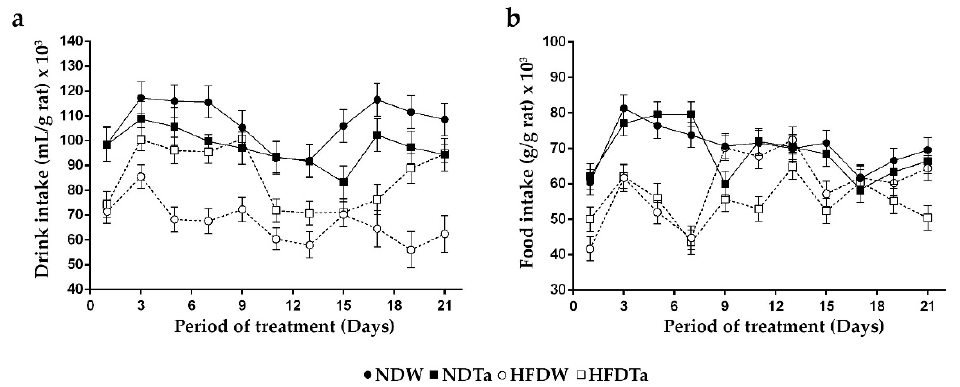
Figure 2. Intake of beverage ( a ) and food ( b ) through a 21-day period since the beverage administration began. Intake values were relativized to the BW of the animals. The graphs include the results of every other day to simplify the figures. Results are expressed as mean ± SEM from two to three independent assays ( n = 5 animals/group). Significant differences were determined by RM two-way ANOVA followed by Fischer’s LSD post-hoc test. Abbreviations: NDW, normal diet + water; HFDW, high-fat diet + water; NDTa: normal diet + Ta; and HFDTa, high-fat diet + Ta.